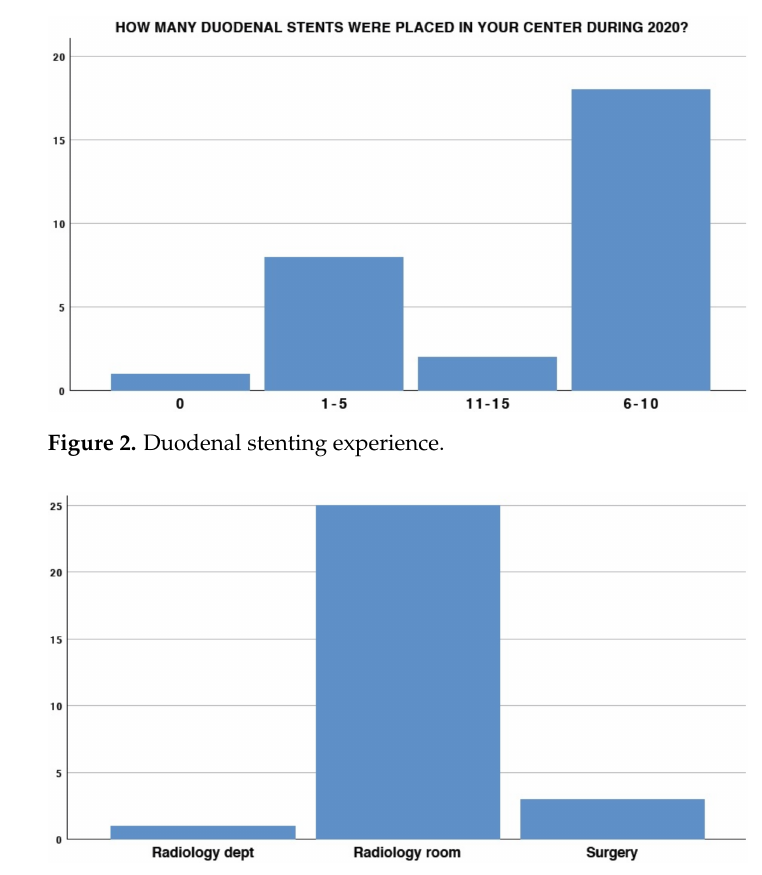
Figure 3. Availability of radiology